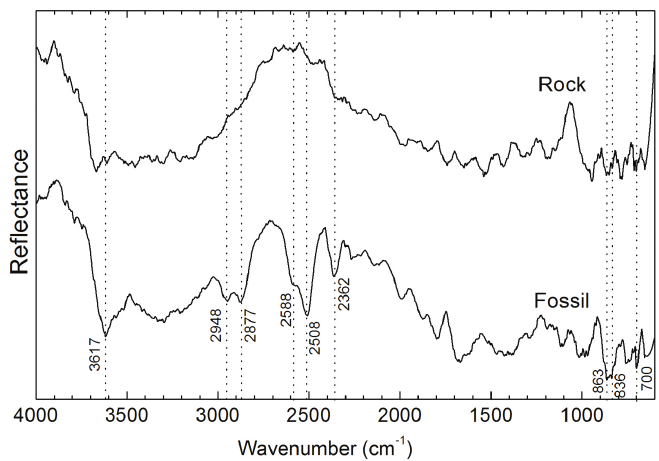
Figure 5. Diffuse reflectance infrared spectra of inner part of Unionoida bivalve and surround rock matrix. The positions of absorption bands that can be distinguish of the noise of spectrum of fossil are indicated in the